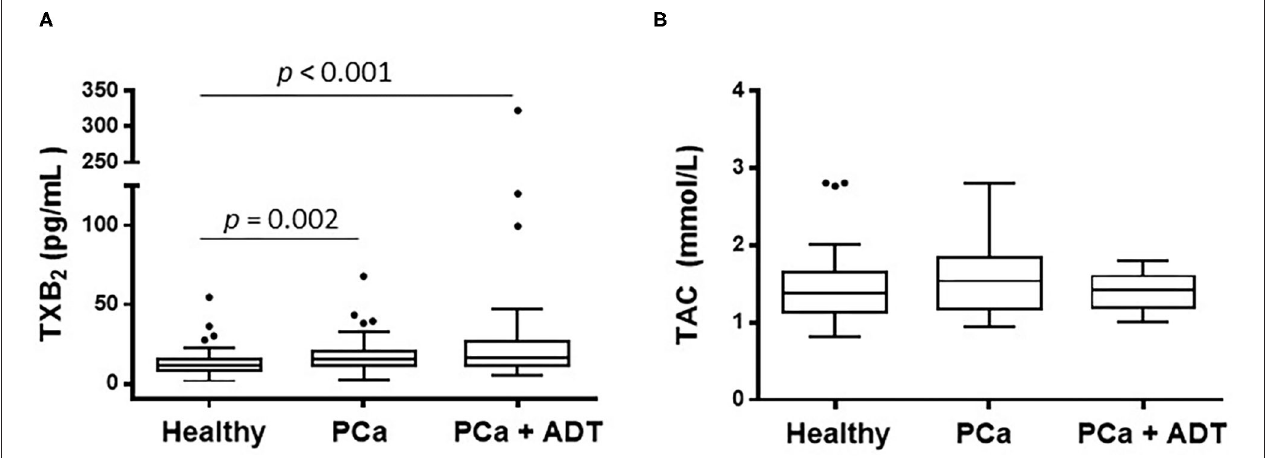
FIGURE 1 | Effect of prostate cancer (PCa) and androgen deprivation therapy (ADT) in PCa patients on the serum concentration of thromboxane A 2 (TXA 2 ) (A) and on the total antioxidant capacity (TAC) (B) . Results are shown as the median (solid line) with the top and bottom of box representing quartiles. The statistical significance, by means of Mann–Whitney U test, is indicated in the corresponding graphs.